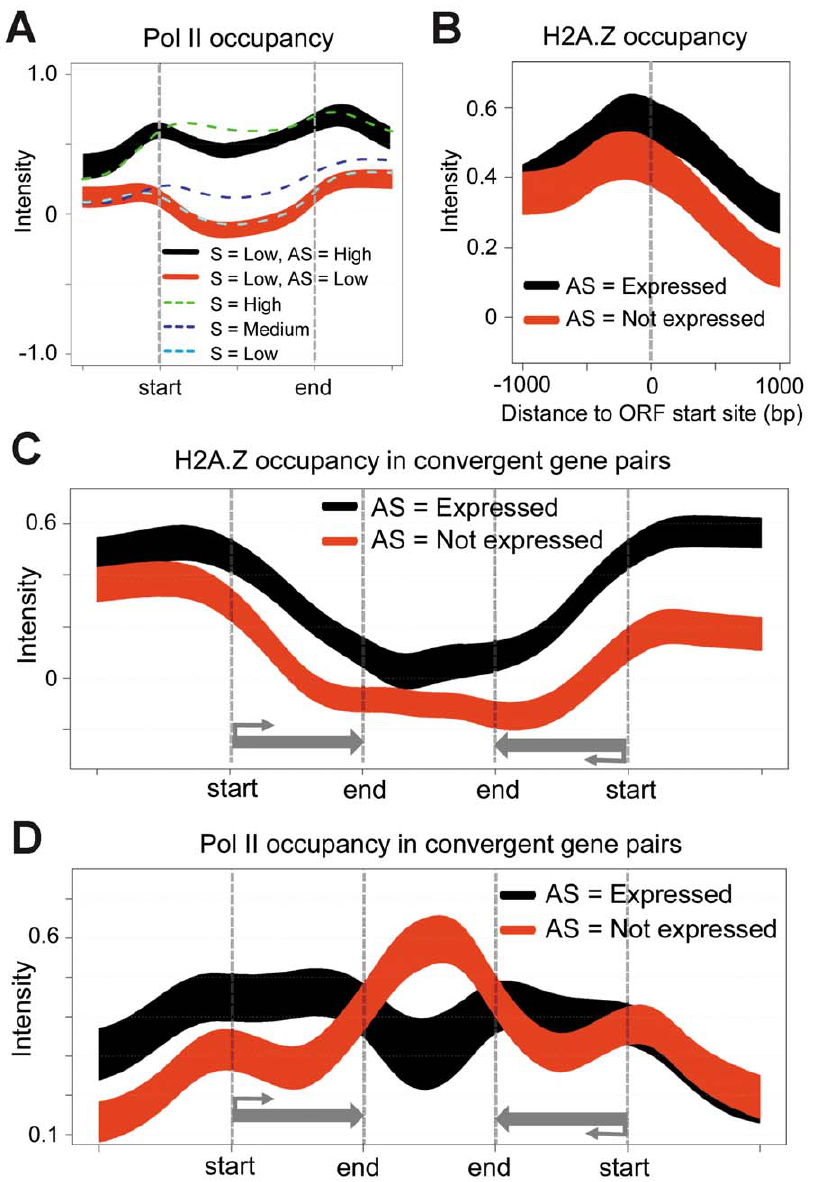
Figure 4. Antisense transcripts have distinct Pol II and H2A.Z occupancy. (A) Pol II occupancy in protein-coding region (ORF), and 1 kb regions upstream and downstream of ORF. The start and the end positions of ORF (sense strand) are indicated. The gene groups defined by sense expression (high, medium and low) are drawn as dashed lines. The weakly expressed genes were further divided into antisense- (black) and sense- dominant (red) groups based on sense/antisense ratio. (B) H2A.Z occupancy at the ORF start site and its surrounding regions. Two gene groups, i.e. genes with antisense expression (black) and without antisense expression (red) are shown. (C) H2A.Z and (D) Pol II occupancy for convergent loci. Two gene groups, i.e. genes with antisense expression (black) and without antisense expression (red) are shown. Compilation of two gene groups (comparable expression distribution of sense transcripts; and presence/absence of antisense expression) were based on the left genes in the convergent pairs. For completeness, the right genes are also shown, which do.